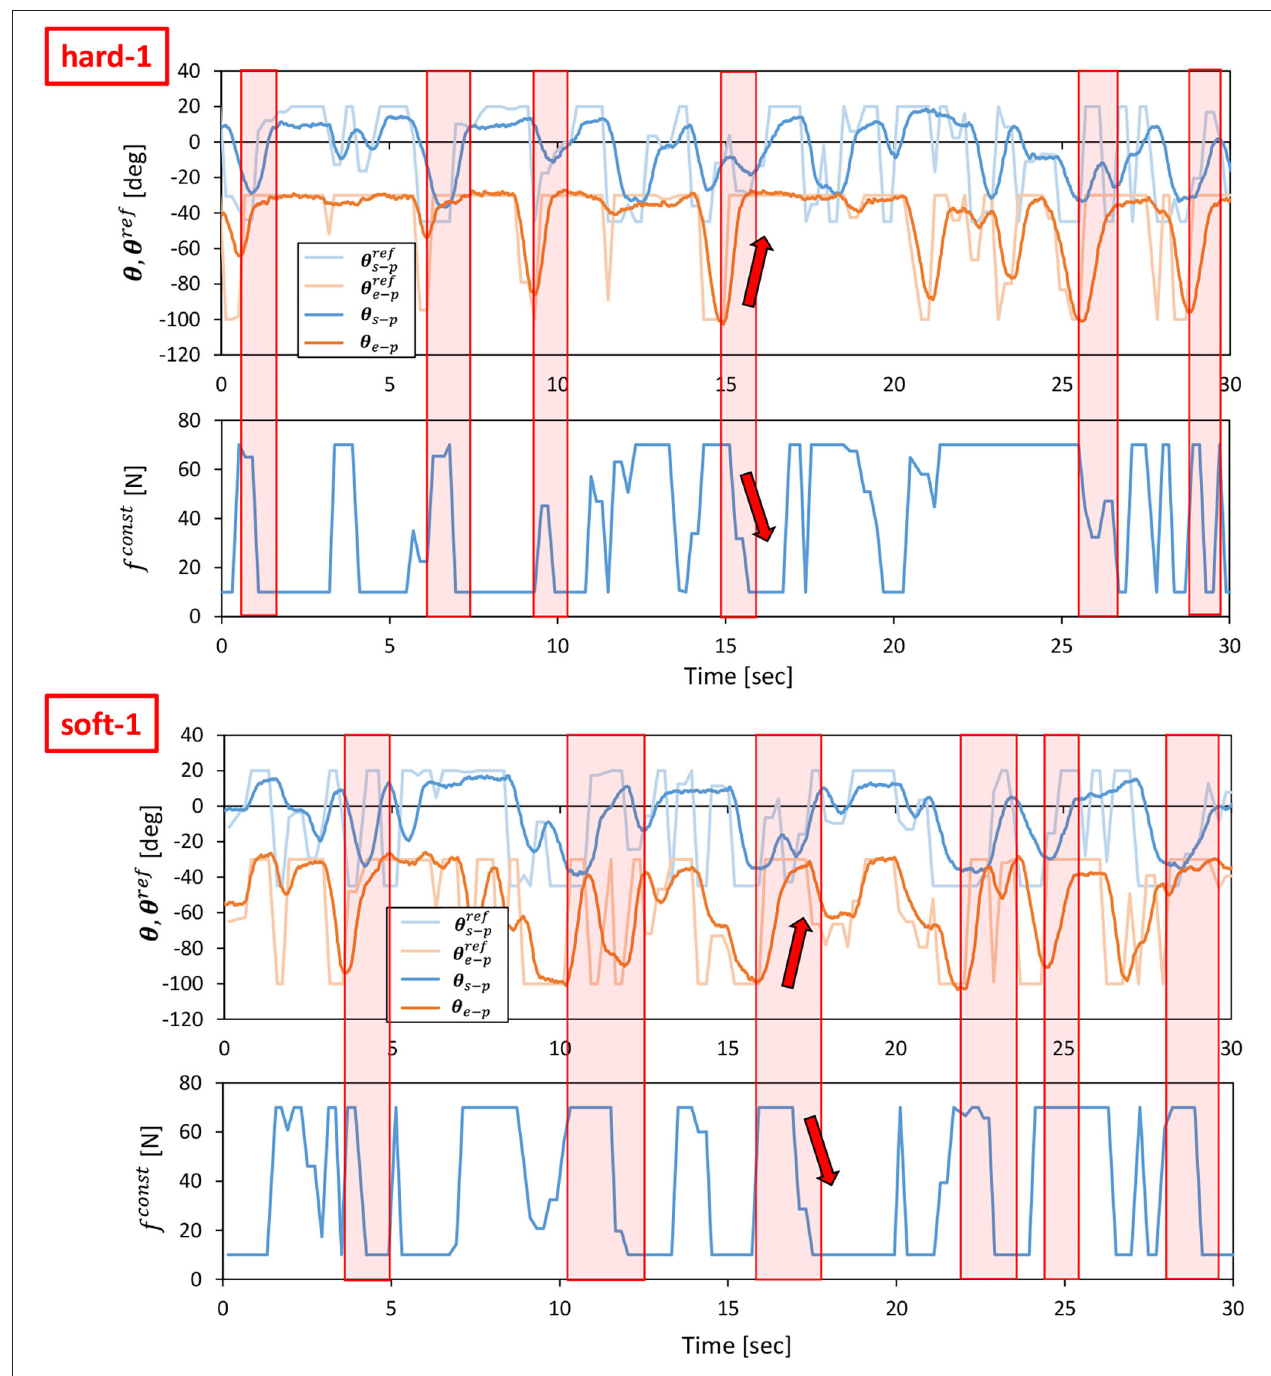
FIGURE 11 | Actual robot experiment: examples of transitions of θ ref , θ , f const , and || z ref − z || 2 when conducting an experiment of dynamic manipulation of hard-1 (upper graphs) and soft-1 (lower graphs) .